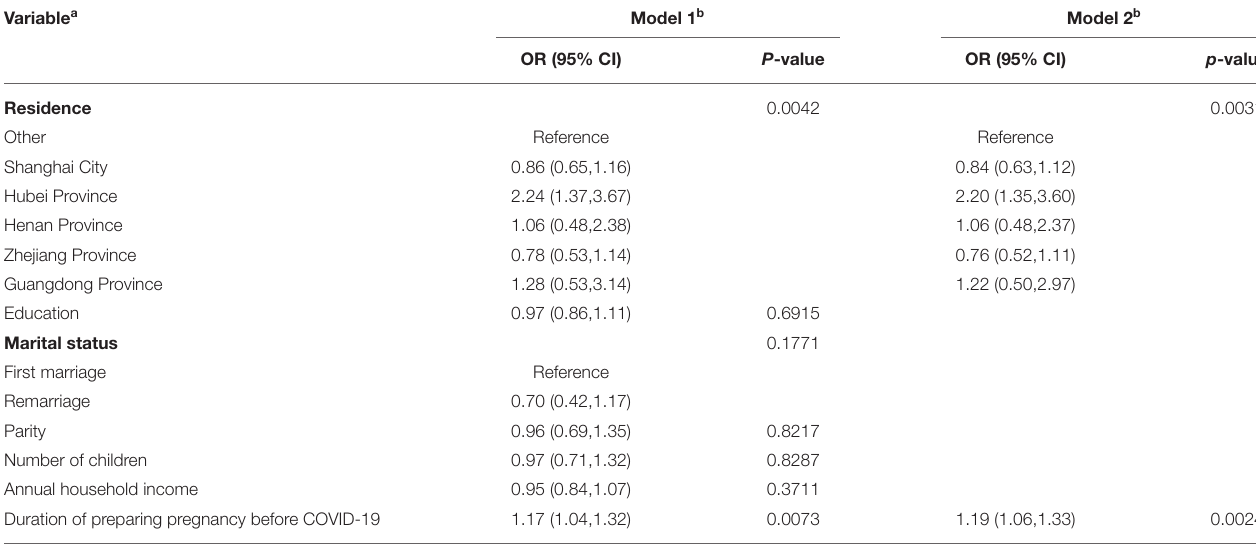
TABLE 3 | Multivariable logistic regression analysis (respondents with fertility intention before